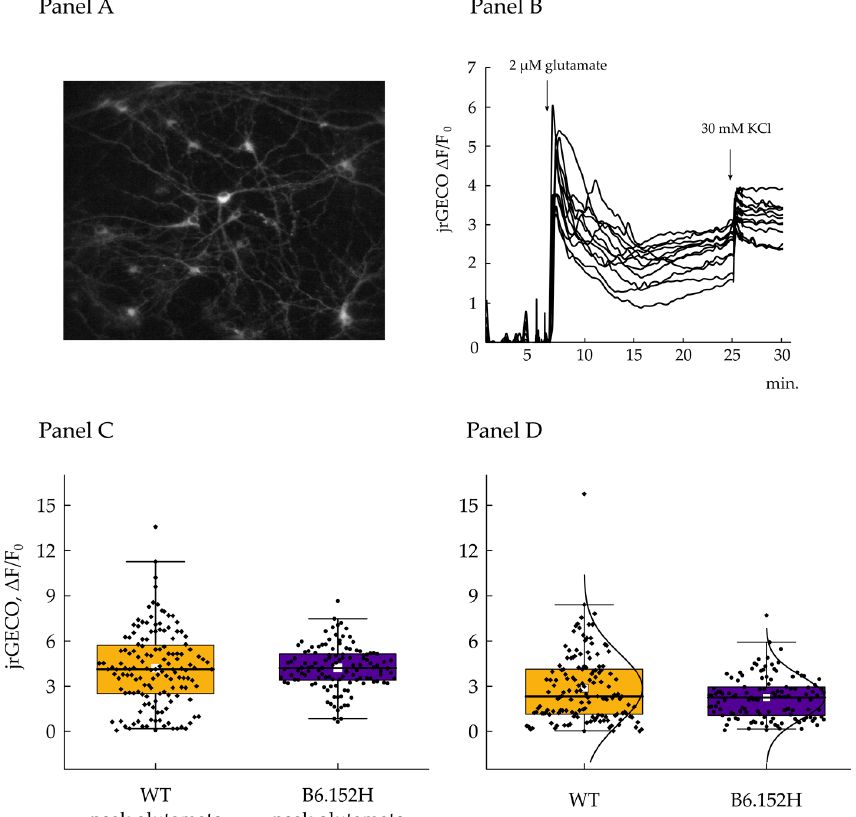
Figure 7. Cytosolic Ca 2+ transient in primary hippocampal neurons induced by glutamate. Panel ( A ), representative image of 14 div hippocampal neurons expressing cytoplasm-targeted jrGECO. Panel ( B ), representative traces of jrGECO fluorescence expressed as the normalized values of the difference between time point F minus the average of the initial 5 min of acquisition (F 0 ); where indicated the cells were challenged with 2 µM glutamate and 30 mM KCl. Panel ( C ), quantification of the jrGECO fluorescence measured at the maximum peak reached after glutamate addition and expressed as normalized difference with initial fluorescence F 0 . WT n = 144 cells, median value = 4.13; B6.152H n = 121 cells, median value = 4.2. Two sample t-test prob. = 0.9; at the 0.05 level, the difference between the means is not significantly different from 0. Panel ( D ), jrGECO fluorescence measured 20 min after glutamate addition and expressed as before. WT n = 144, median value = 2.33; B6.152H n = 121 cells, median = 2.24; Mann–Whitney test Asymp prob = 0.1. At the 0.05 level, the two distributions are not significantly different. Box plot: Box height, 25–75%; whiskers, 1–99%; white square: Mean; transverse line: Median; curve: Normal distribution.